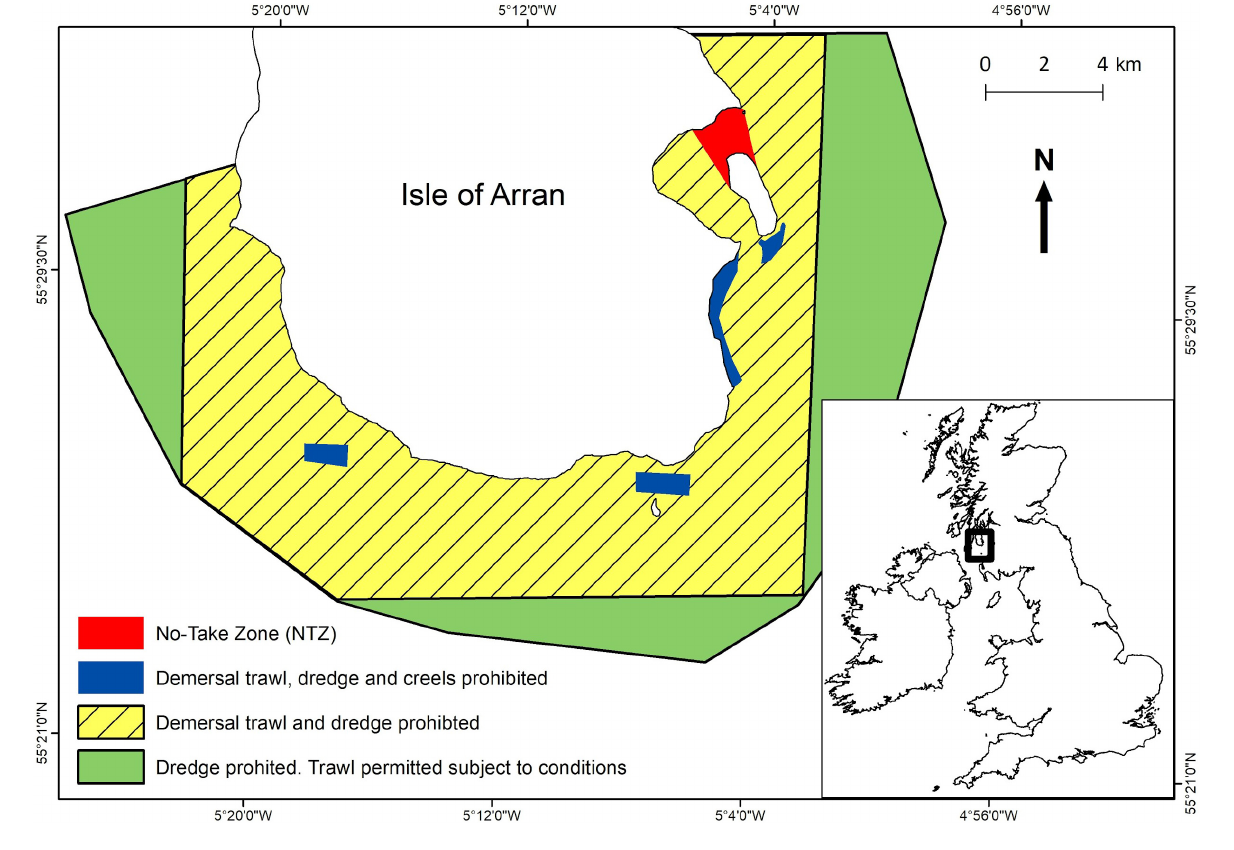
Frontiers in Marine Science |